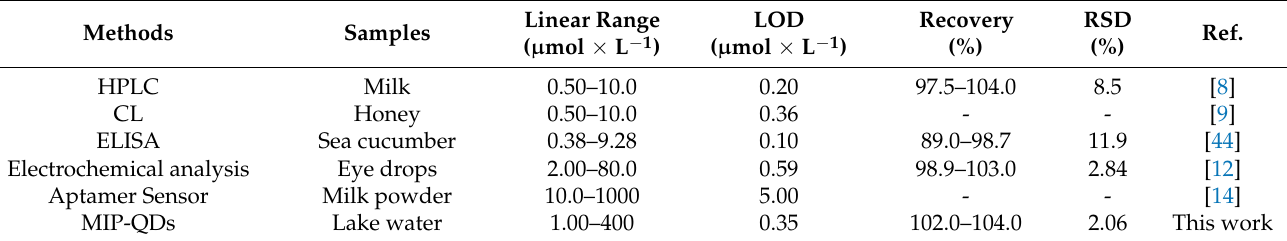
Table 2. Comparison with other reported methods for detecting